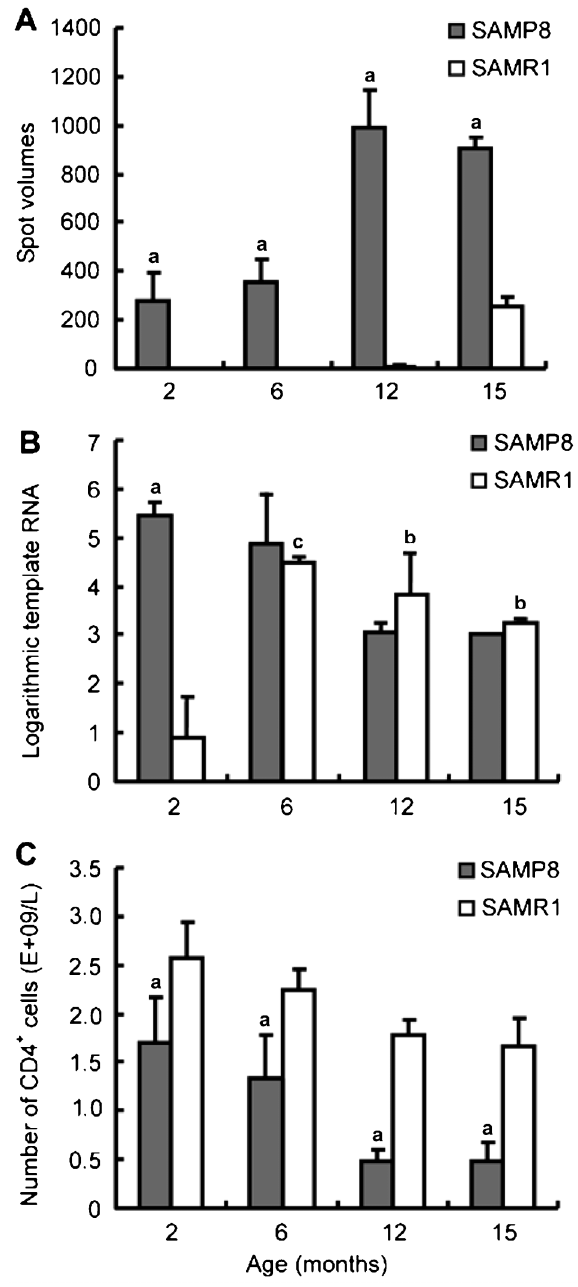
Figure 3. M-T413 expression in sera and splenocytes and CD4 + T cell count in peripheral blood. A , The spot volume of M-T413 was greatly increased in SAMP8 mouse sera compared to SAMR1 mice atallages. a P , 0.01 vs age-matchedSAMR1(Studentpaired t -test). B , M-T413 mRNA level was higher in SAMP8 mouse splenocytes than in SAMRI mouse splenocytes at 2 months of age. In SAMR1 mouse splenocytes, mM-T413 RNA was elevated from 6 months of ageandmaintainedatahigherleveluntil15monthsofage. a P , 0.01 vs age-matched SAMR1. b P , 0.05, c P , 0.01 vs 2-month-old SAMR1 (Student paired t -test). C , The CD4 + T cell count was much lower in SAMP8 mouse blood compared to SAMR1 mice at all ages. a P , 0.01 vs age-matched SAMR1 (Student paired t